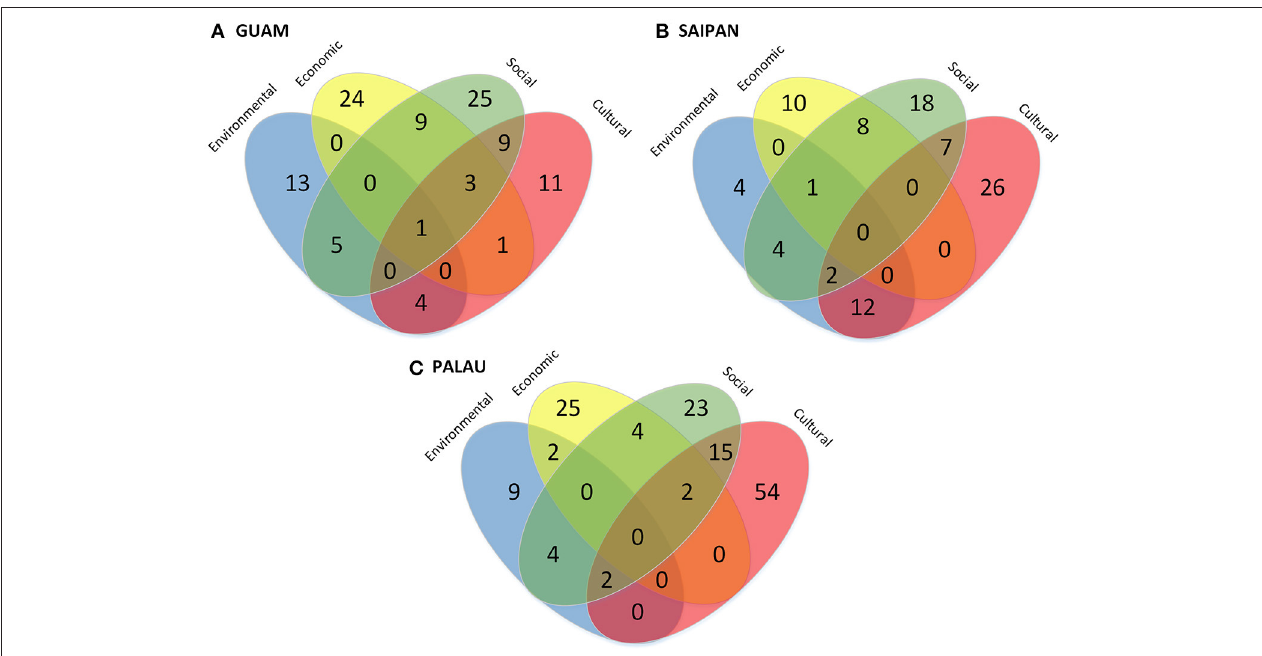
FIGURE 2 | Venn diagrams illustrating the number of respondent identified values for: (A) Guam; (B) Saipan; and (C) Palau. Overlaps indicate value sub-elements that were shared across groupings.